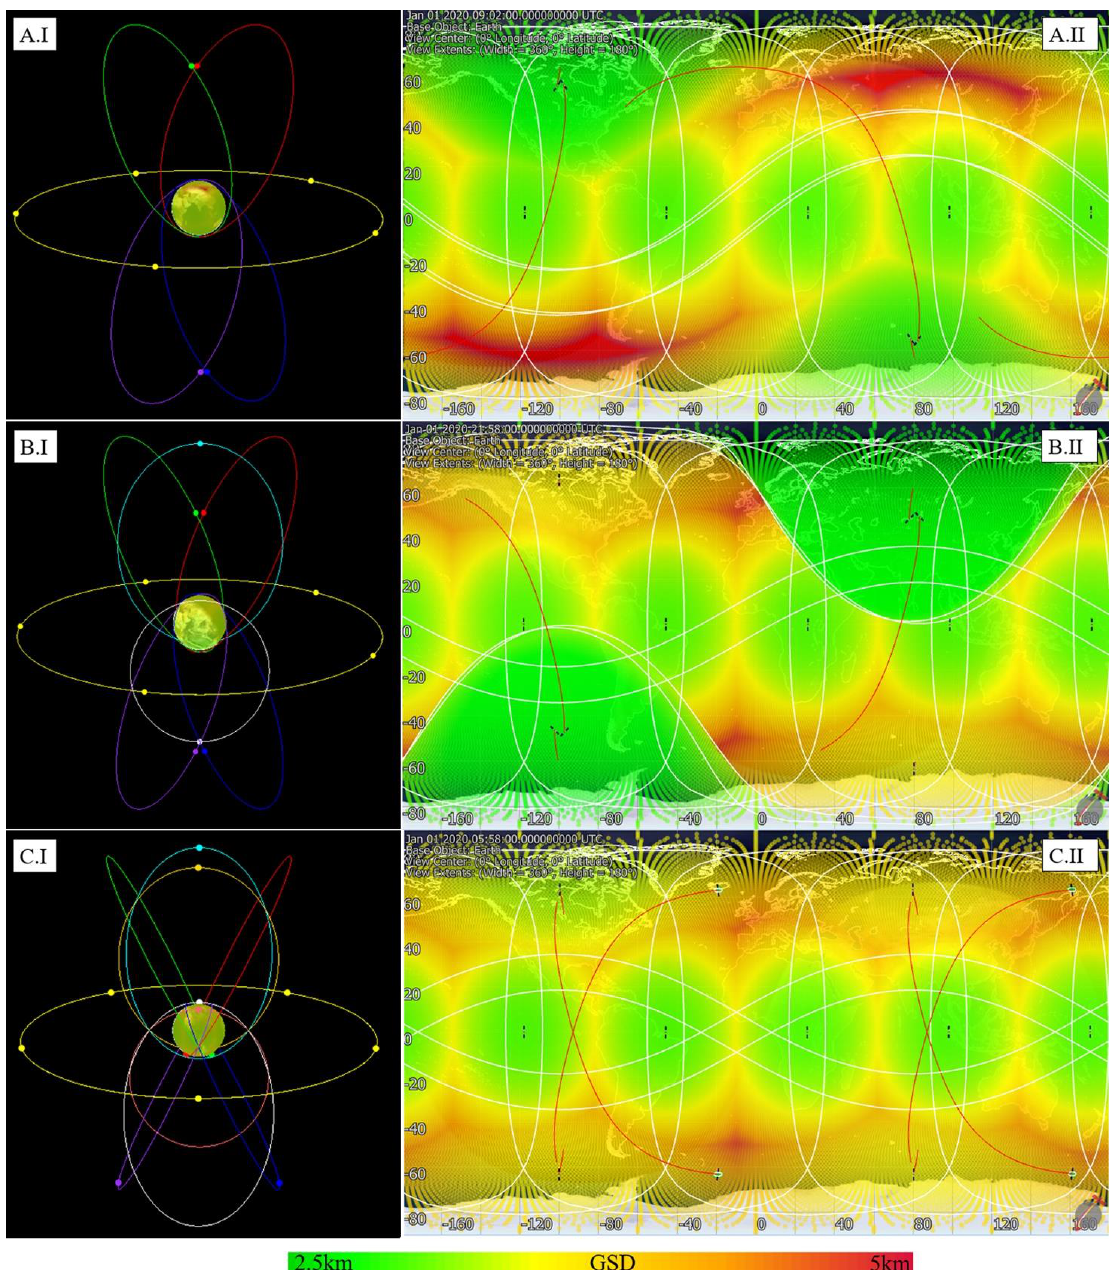
Figure 10. Constellation formations (I) and global distribution of GSD (II) at the time of maximum distortion for the Nine ( A ), Eleven ( B ) and Thirteen ( C ) satellite cases.